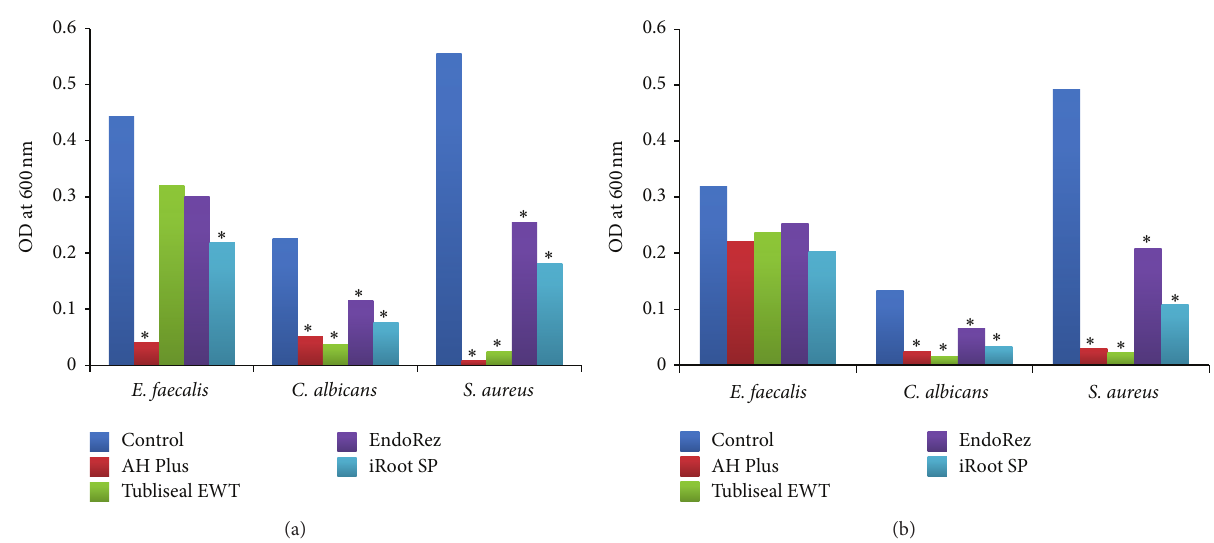
Figure 1: Comparison of time corrected mean microbial growth in (a) presence of tested sealers, A well and (b) absence of tested sealers, B well. The endodontic sealers showing significant antimicrobial property ( 𝑃 < 0.05 ) compared to the control are marked with ∗ .